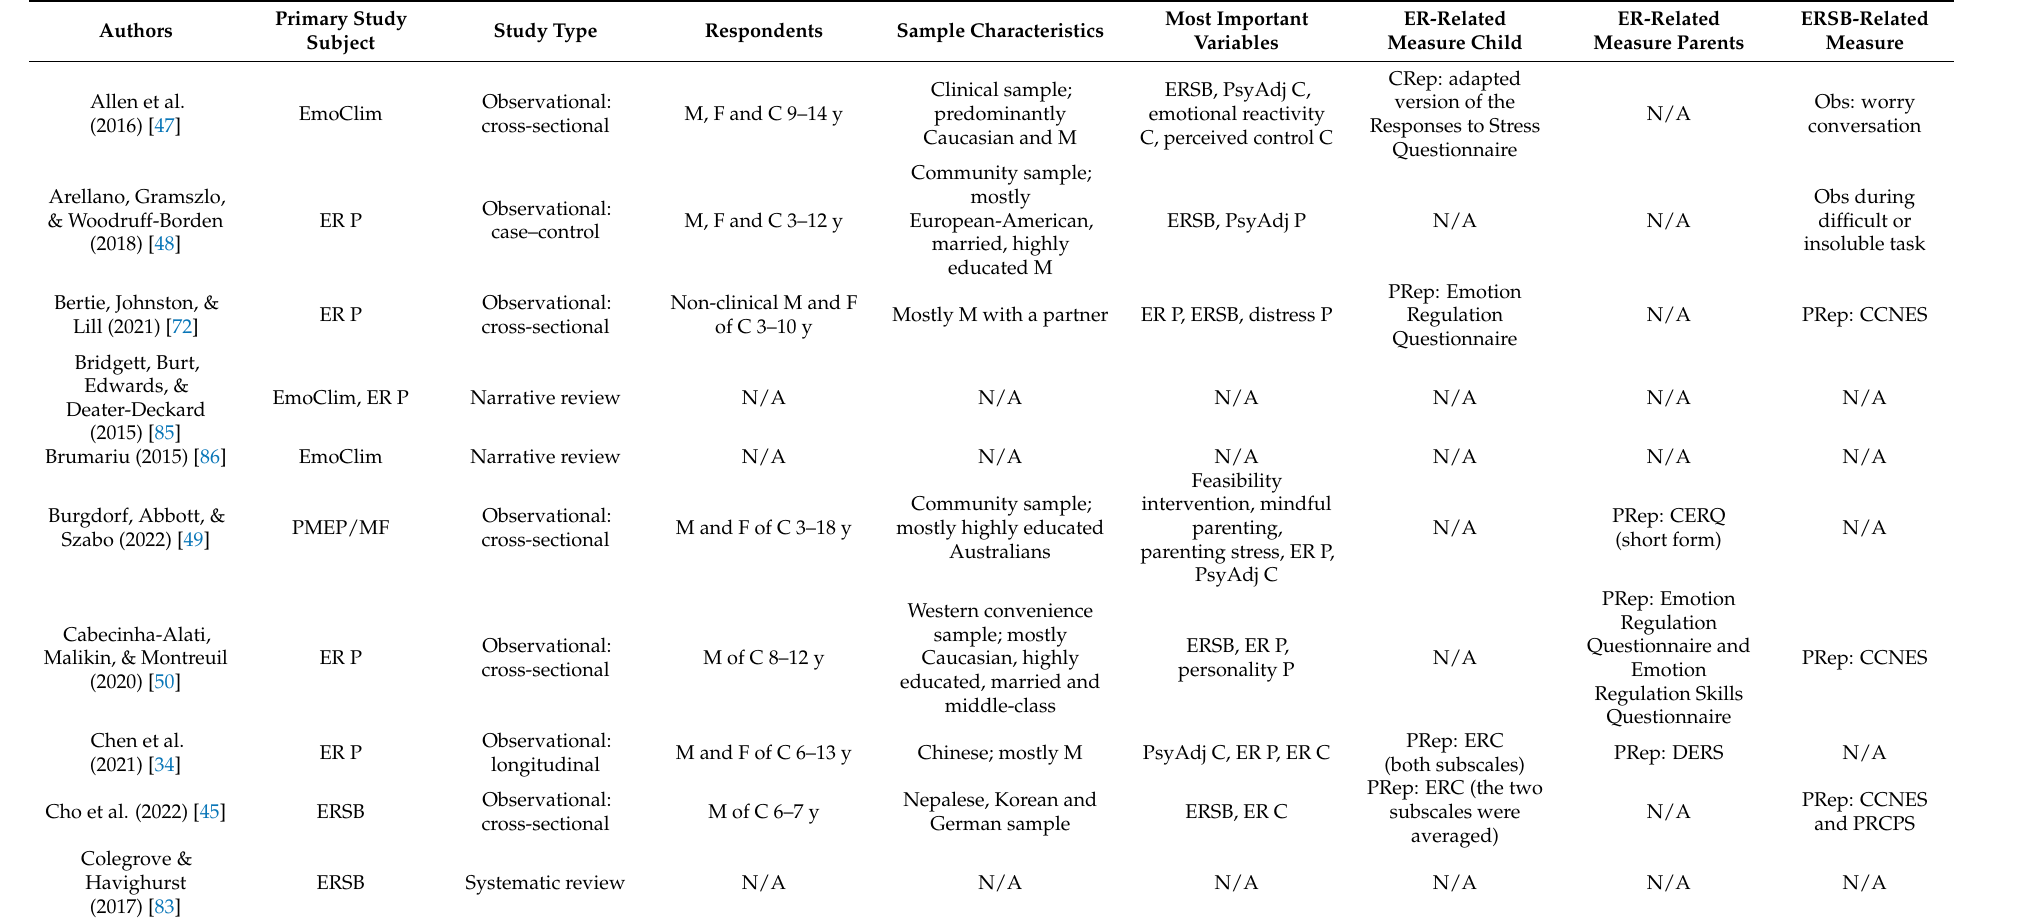
Table 1. Overview of the Included Studies and their